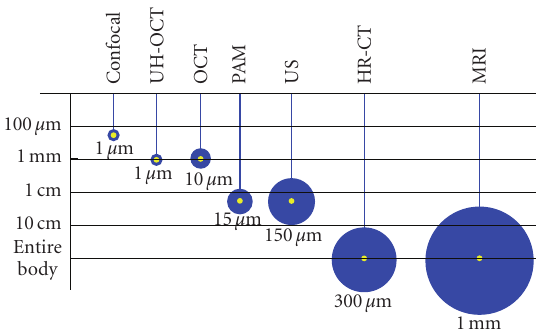
Figure 1: Spatial resolution (circles) and axial resolution ( Y -axis) of several medical imaging techniques. Light methods are 1-2 orders of magnitude higher in spatial resolution. (HR-CT: high resolution computer tomography, MRI: Magnetic resonance imaging, the rest in the text.).